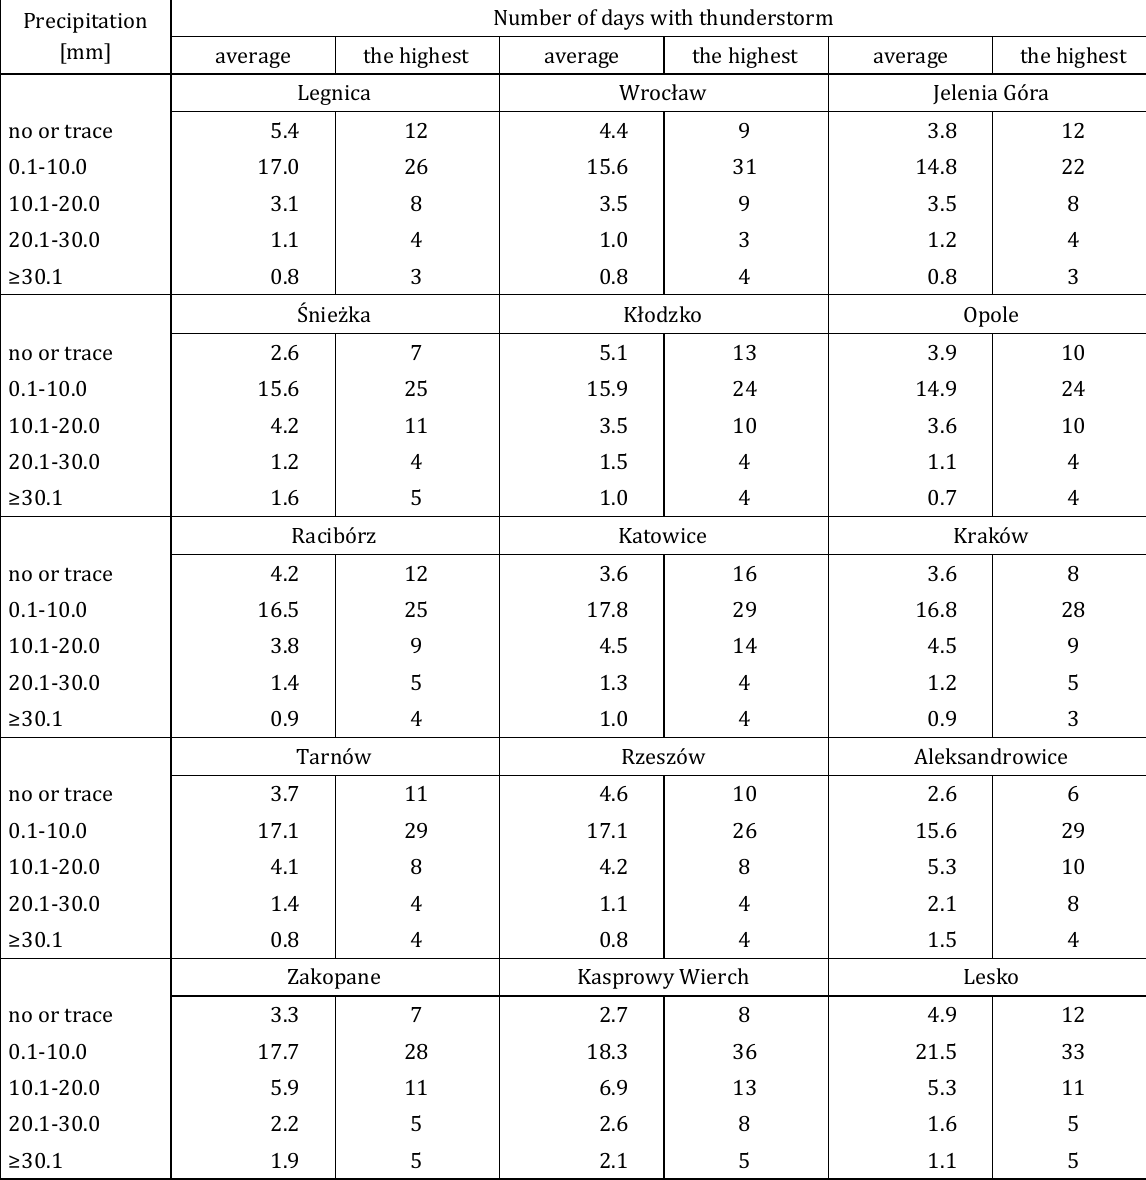
Table 2. Annual number of days with thunderstorm and precipitation in the period 1951-2010 Number of days with thunderstorm Precipitation [mm] average the highest average the highest average the highest